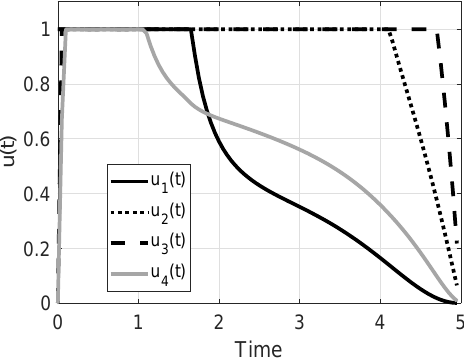
Figure 11. Case 2: evolution of the optimal control